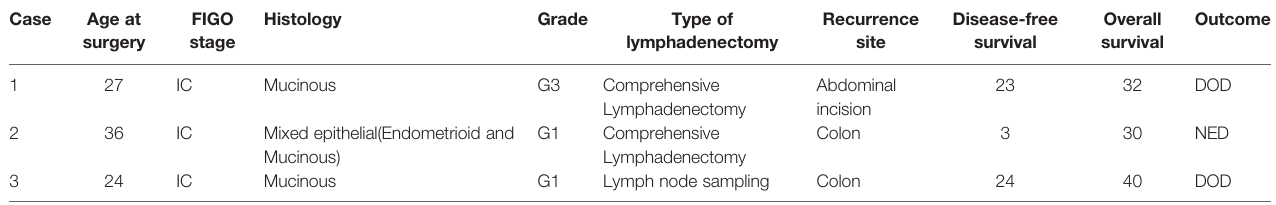
TABLE 2 | The information of the patients who developed